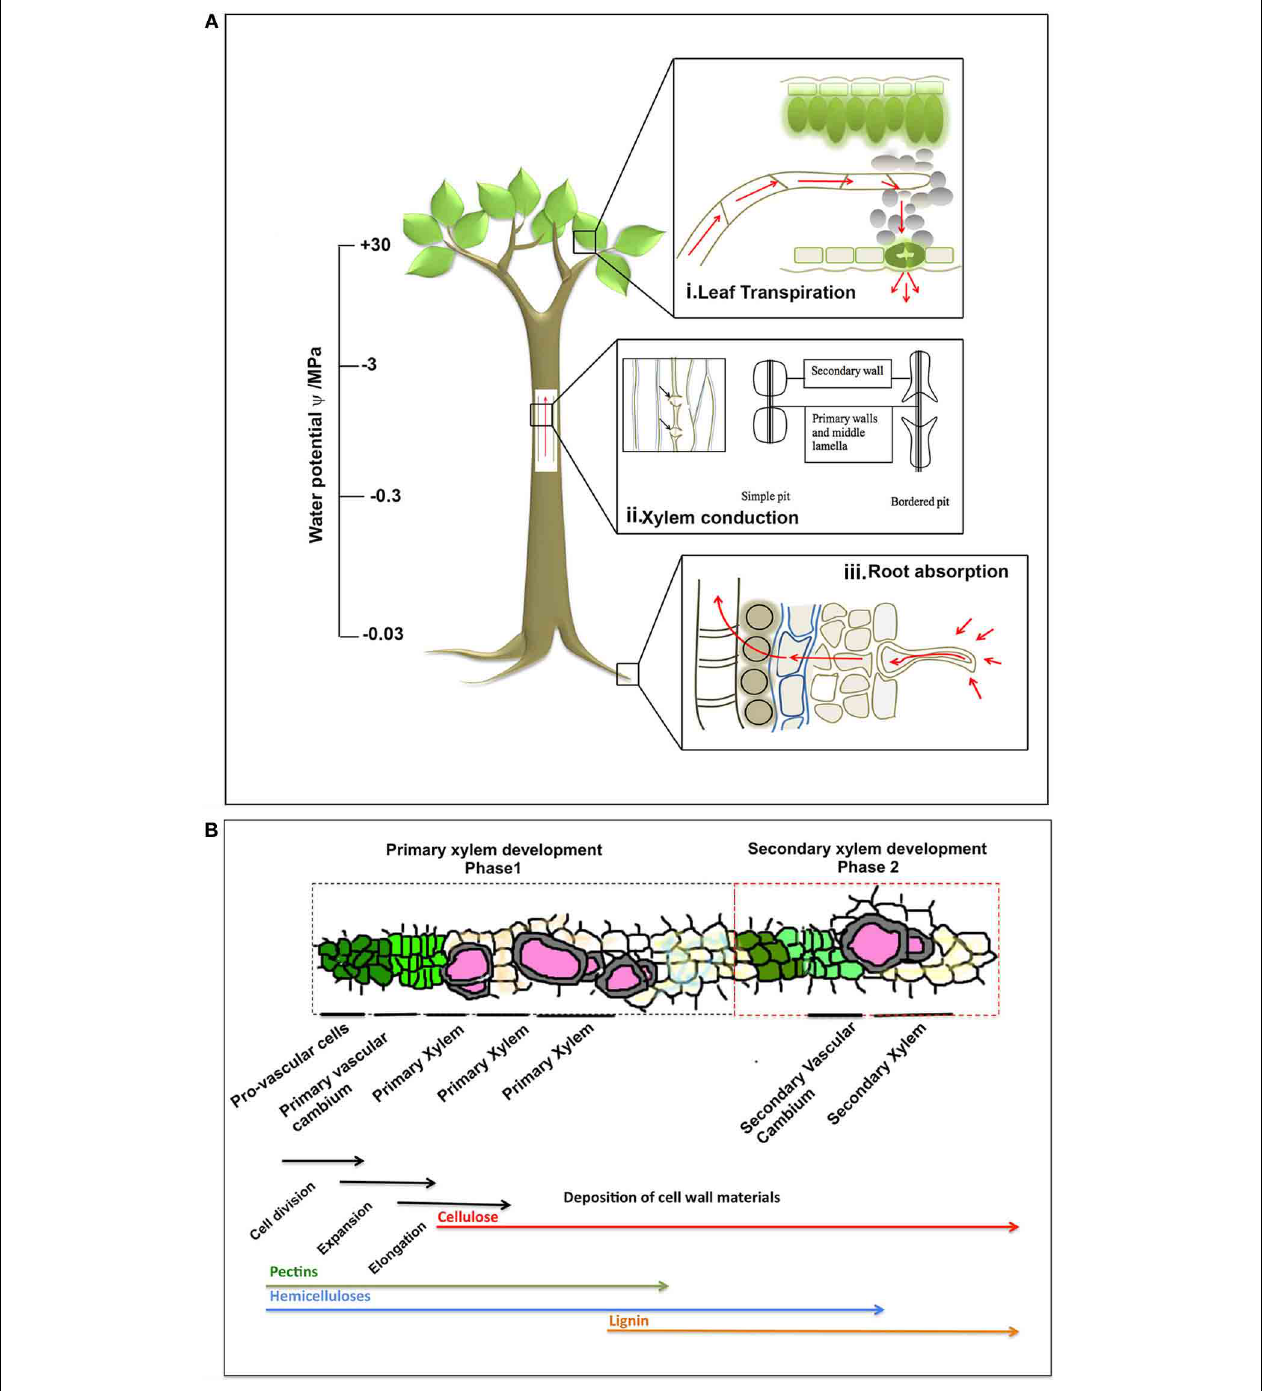
FIGURE 1 | (A) The soil-plant-air continuum functioning in maintenance of water transport column. The plant root takes up water from soil, and the water column is maintained continuous along the xylem. The continuity across the xylem vessel is maintained by several intrinsic physical properties of water, input from the adjoining living cells and transpirational pool. The rough estimate of pressure along the vascular cylinder is presented in the scale bar (image not to actual scale). (B) A schematic of xylogenesis, adapted and modified from Hertzberg et al., 2001. The two phases of xylem